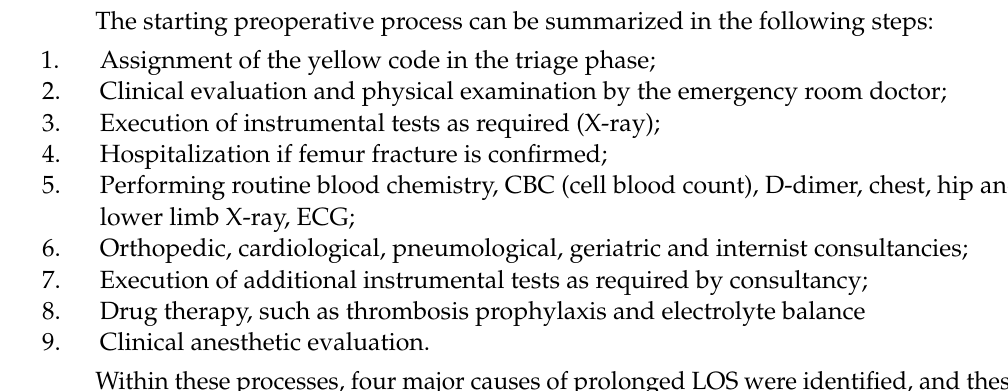
Figure 1. Run chart of preoperative LOS before improvement. The red line indicates the average value of 5.6.